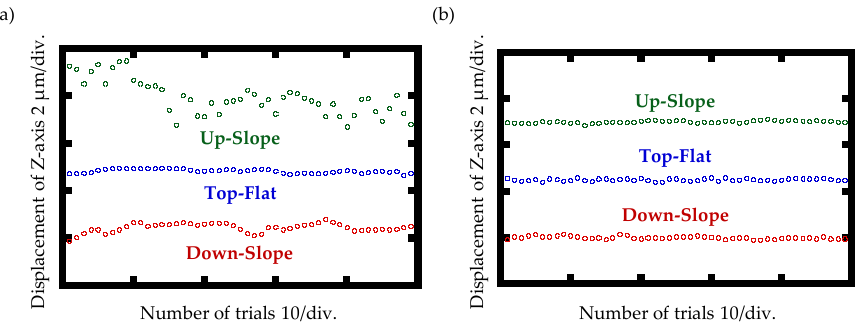
Figure 9. Measurement repeatability: ( a ) With cantilever beam; ( b ) with double-sided beam.